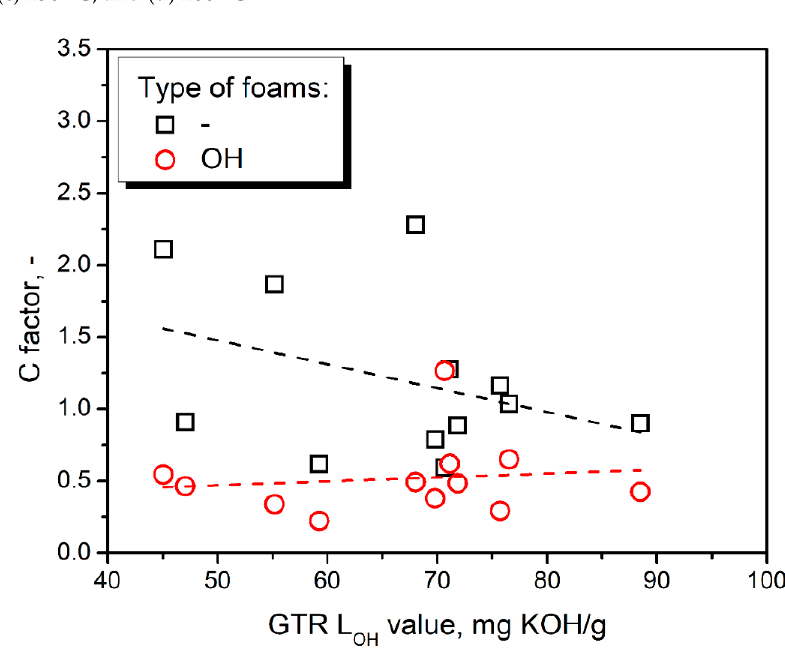
Figure 9. The relationship between GTR L OH values and the C factor of prepared PU/GTR compo-